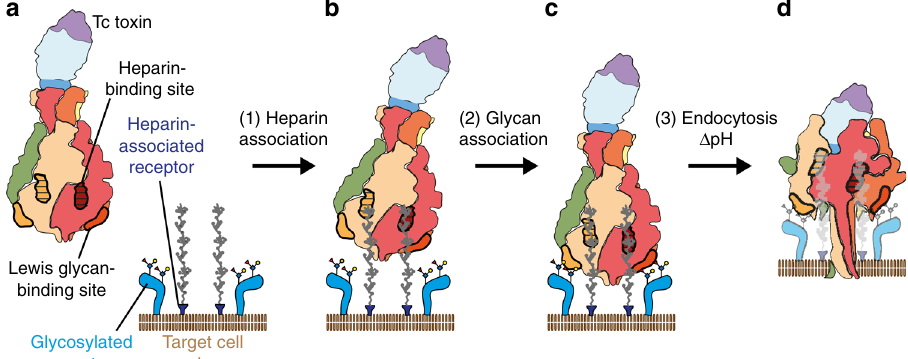
Fig. 5 Model of the intoxication mechanism of Tc. a Tc toxin and target cells with multiple glycosylated and heparin-associated receptors. The binding sites for heparin and Lewis antigens are indicted on two protomers. b Tc toxin associates to heparin-associated receptors on target cells. c In the second association reaction, Tc toxin binds to additional glycosylated receptors, resulting in a tighter toxin-cell complex. d Upon endocytosis, the shift of pH to acidic values induces prepore-to-pore transition and membrane permeation of the